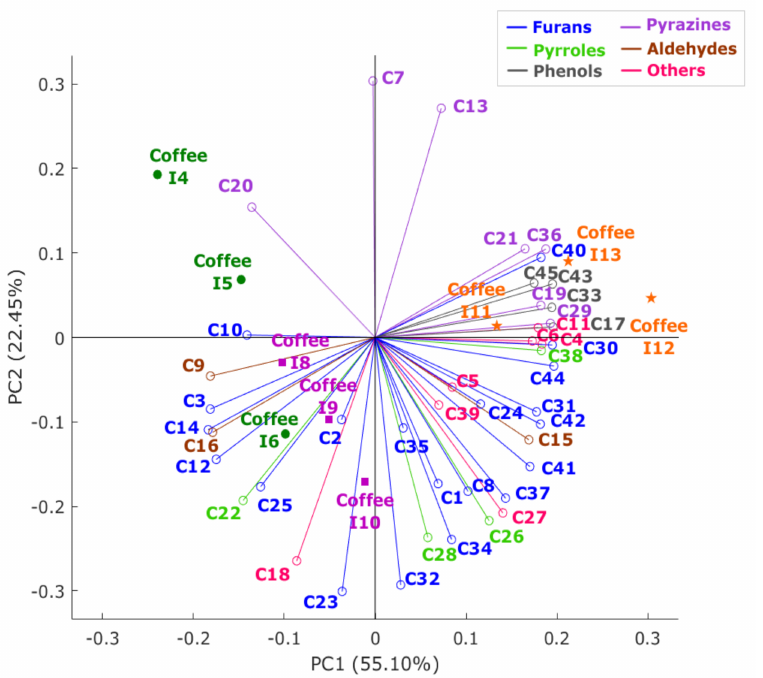
Figure 4. Principal component analysis biplot depicting the volatile aromatic compounds and coffee samples. Each vector color represents a functional group to which the compounds belong. Abbreviations of the volatile aromatic compounds can be found in Table 3 and samples in Table